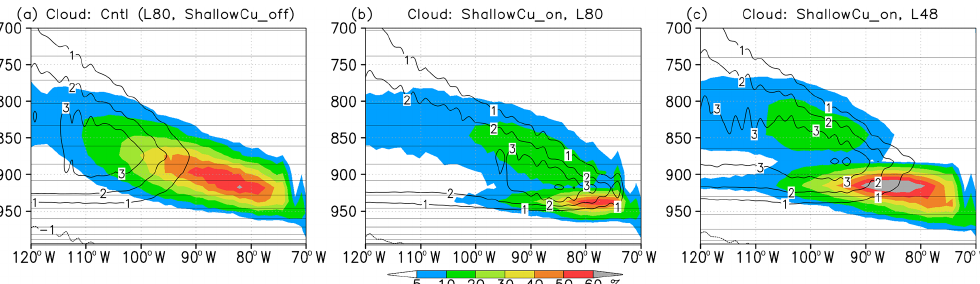
Figure 6. Cross sections of cloud fraction (color, %) along 20 ◦ S for January. (a) The control model (L80, a treatment of shallow convection suppressed under stratocumulus conditions), (b) the same as (a) but where shallow convection can be active even under stratocumulus conditions, and (c) the same as (b) except for vertical resolution L48. Horizontal straight lines show the vertical model layers, and contours show the heating rate of the convection scheme (Kd − 1